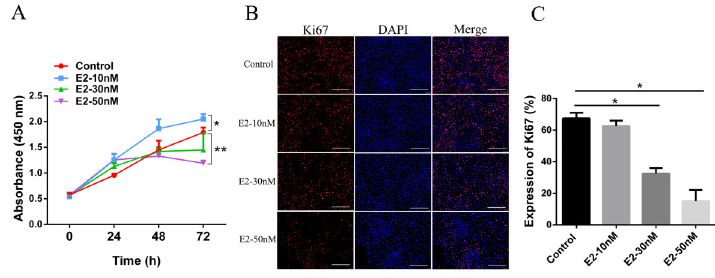
Figure 3. A , Cell proliferation at different times was detected by CCK8 assay in normal human endometrial epithelial cells. B and C , Detection of Ki67 expression by immuno fl uorescence staining of human endometrial epithelial cells treated with different doses of estrogen (E2) (magni fi cation 100 (cid:1) , scale bar 100 m m). Data are reported as means ± SD. *P o 0.05, **P o 0.01